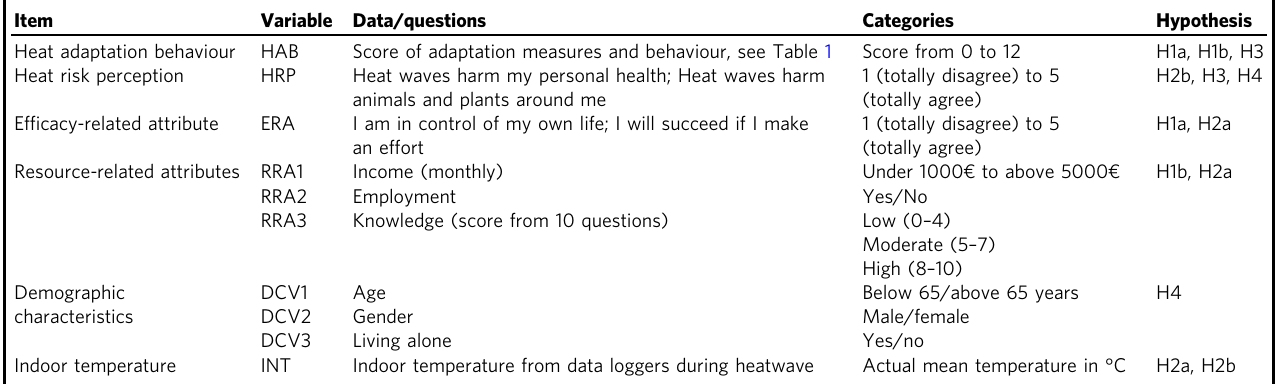
Table 8 Overview of variables and constructs used for hypotheses testing.